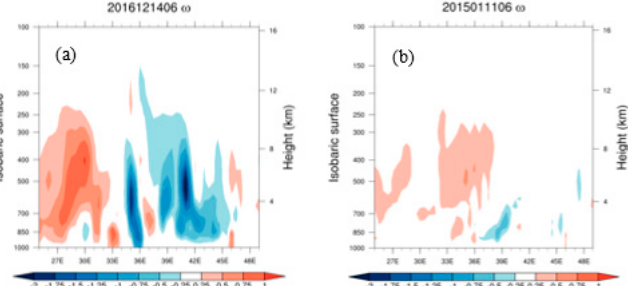
Figure 7. Vertical cross-section of vertical velocity (unit: 10 − 3 Pa/s) during two strong rainfall days along 34–36 ◦ N (( a ) 20161214 strong case, ( b ) 20150111 weak case). along 34–36° N (( a ) 20161214 strong case, ( b ) 20150111 weak case).